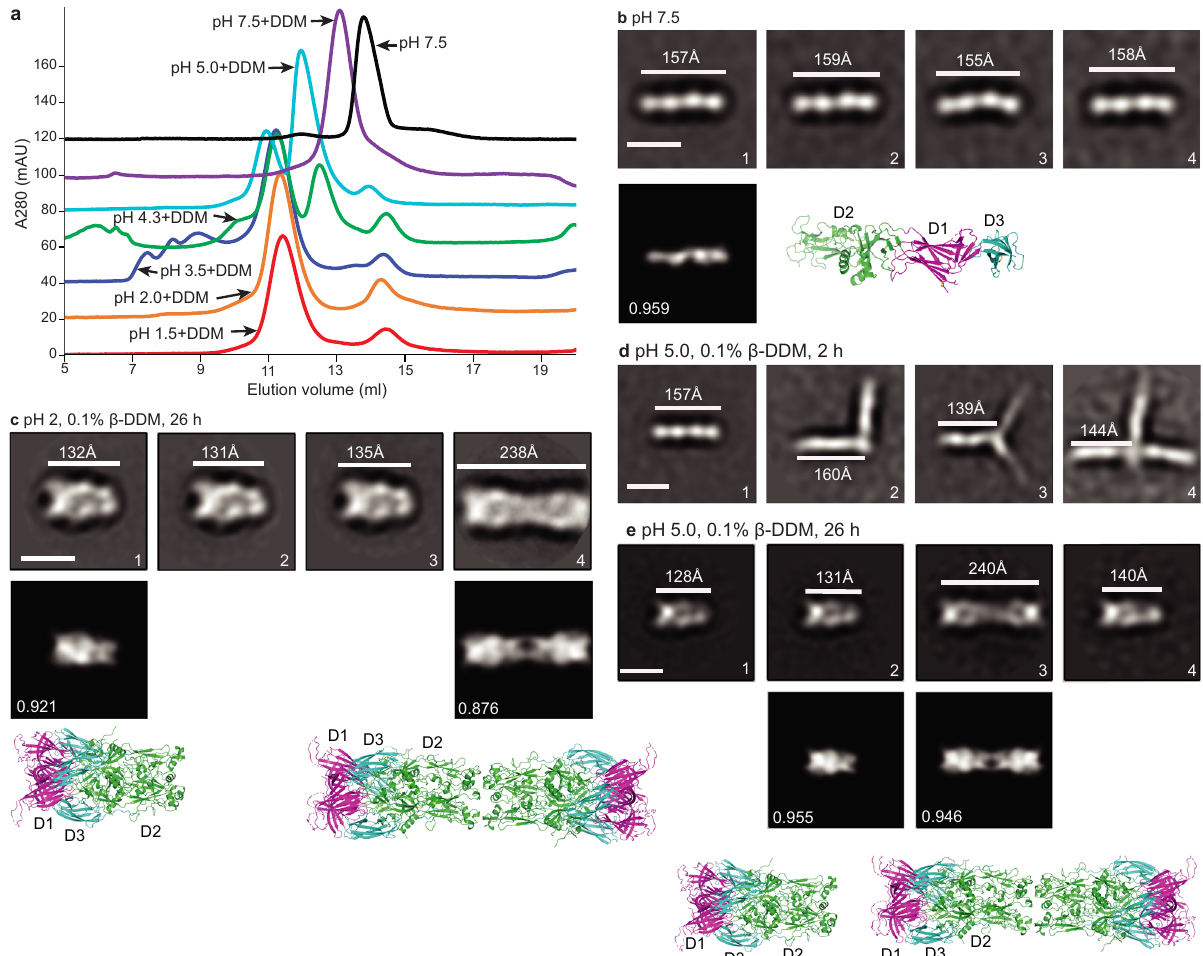
Fig. 5 Pre, post, and intermediate fusion states of Cyani HAP2. a Size exclusion chromatography of Cyani HAP2 treated with or without β -DDM at indicated pH values at 37 °C for 26 h. Pro fi les are separated from one another by successive increases of 20 A280 mAU on the y axis. b – e Representative class averages of Cyani HAP2 treated as shown above each panel. Scale bars of 10 nm are shown in left-most class averages. The length of particles (white lines) was measured. Best cross-correlating crystal structure projections and cross-correlation coef fi cient are shown below selected class averages with corresponding crystal structure orientation as an enlarged ribbon diagram. The experiments of b , d , e were repeated twice and of c three times with essentially identical results. All class averages are shown in Supplementary Figures 2 and